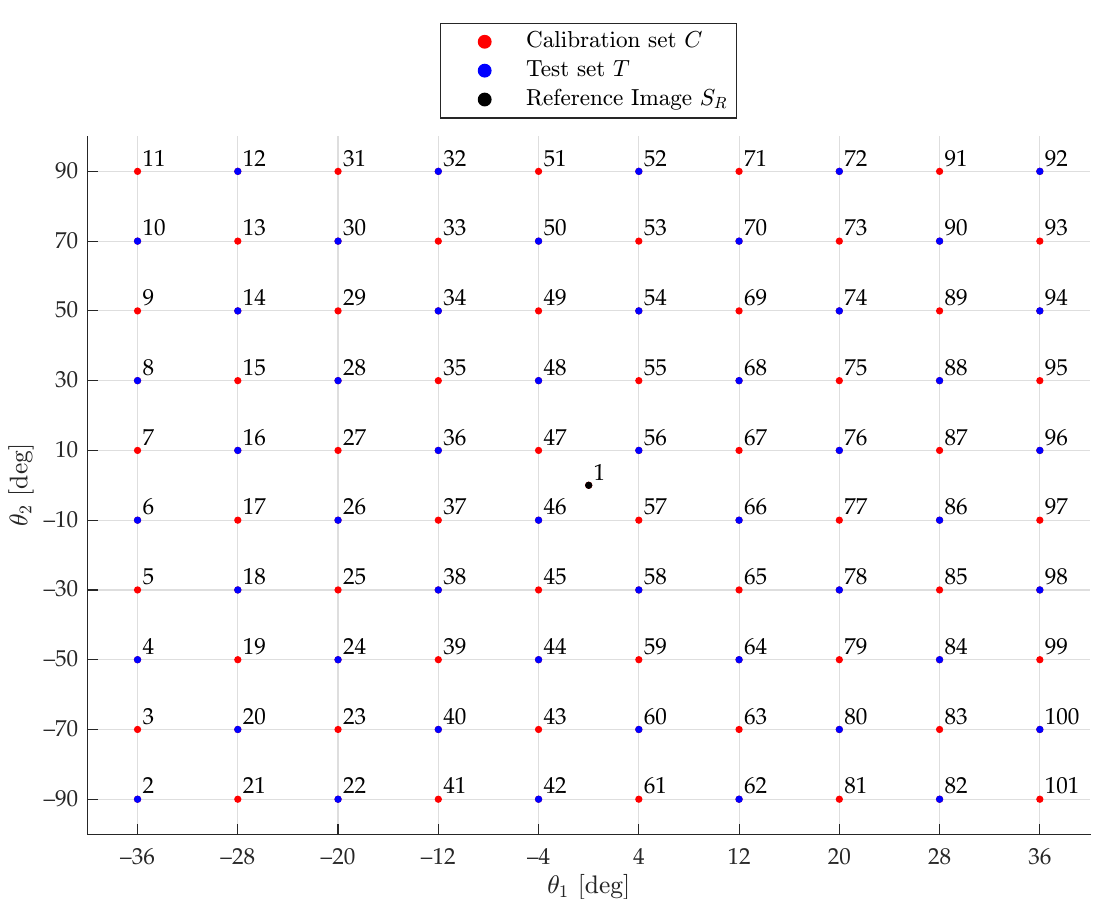
Figure 6. Acquisition set A within the joint configuration Space S ; the red points constitute the Calibration set C , whereas the blue are the Test set T and black is the reference. The number next to a point of coordinates ( θ 1 , θ 2 ) denotes the index i of the corresponding image; any combination of the indices i highlighted in red constitutes a possible subset H of size K